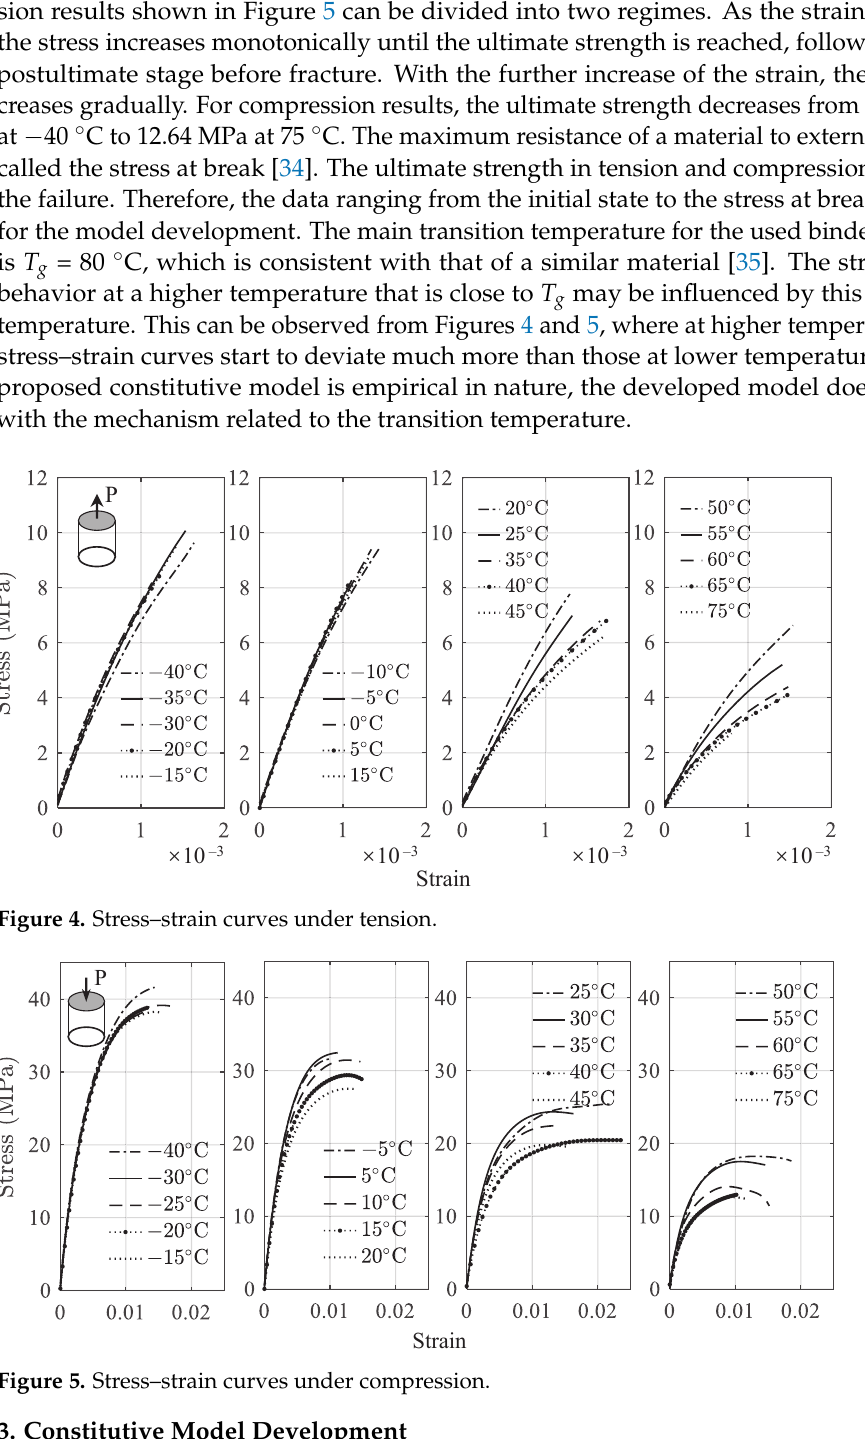
Figure 5. Stress–strain curves under